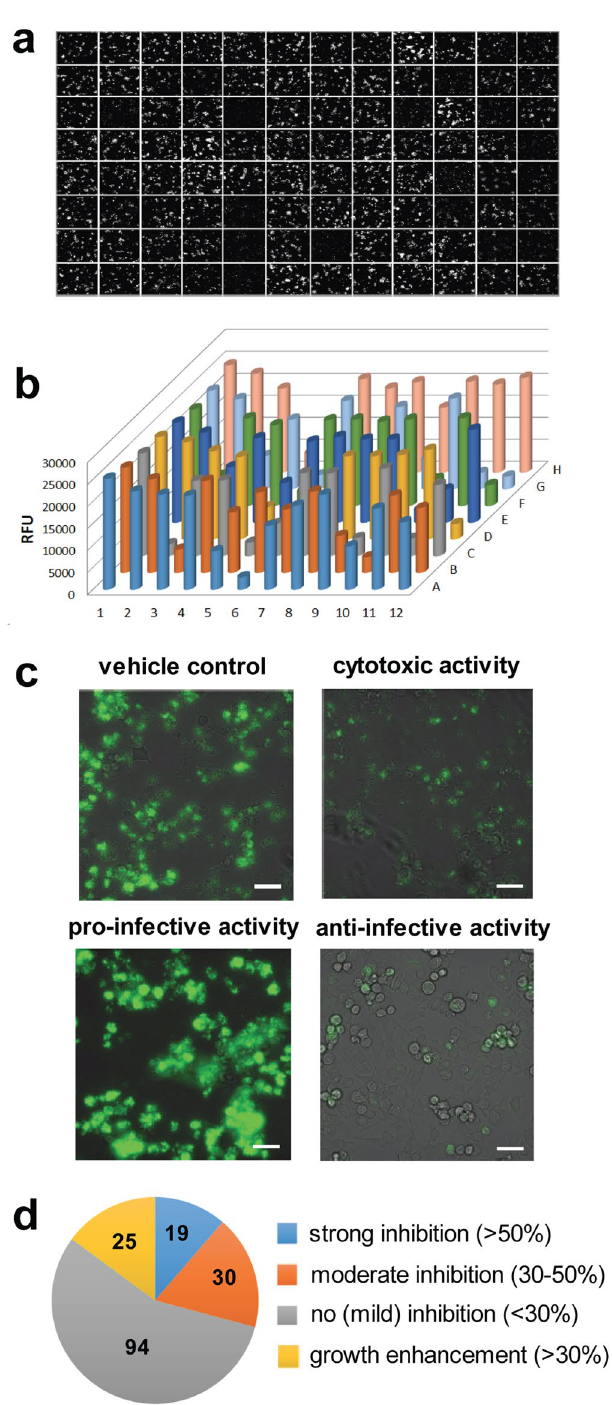
Figure 4. Characterization of anti-infective activities of GSK TB-set compounds in a mammalian infection assay. ( a ) Confocal microscopy of 10 5 BV2 microglial cells infected with M. marinum msp12::GFP, 60 hours incubation time in DMEM medium supplemented with bovine serum in a 96-well plate. Compounds derived from GSK TB-set were added at 10 μ M dissolved in DMSO. ( b ) 3D-chart representing quantification of fluorescence in GSK TB-set. ( c ) Confocal/brightfield microscopy of BV2 cells infected with M. marinum msp12::GFP in the presence of vehicle control (B), cytotoxic (C), anti-infective (D) and pro-infective (E) compounds. 10 5 BV2 cells were transferred to the wells. ( d ) Pie chart representing summarized results of growth inhibitory activity of 168 compounds in A. castellanii infection assay. The analysed set included compounds that displayed inhibition of more than 50% normalized RFU (blue), moderate inhibition between 30 and 50% (red), compounds that showed less than 30% inhibition (grey) and compounds that displayed increase of RFU by more than 30% (yellow). The scale bar corresponds to 500 µ